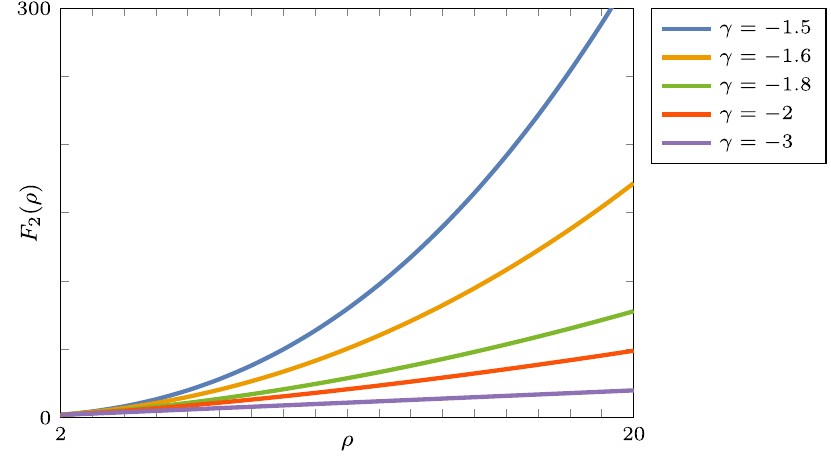
Figure 2: Graphs of F 2 ( ρ ) for γ ∈ { − 3, − 2, − 1.8, − 1.6, − 1.5 } , with a + = 1 and a −